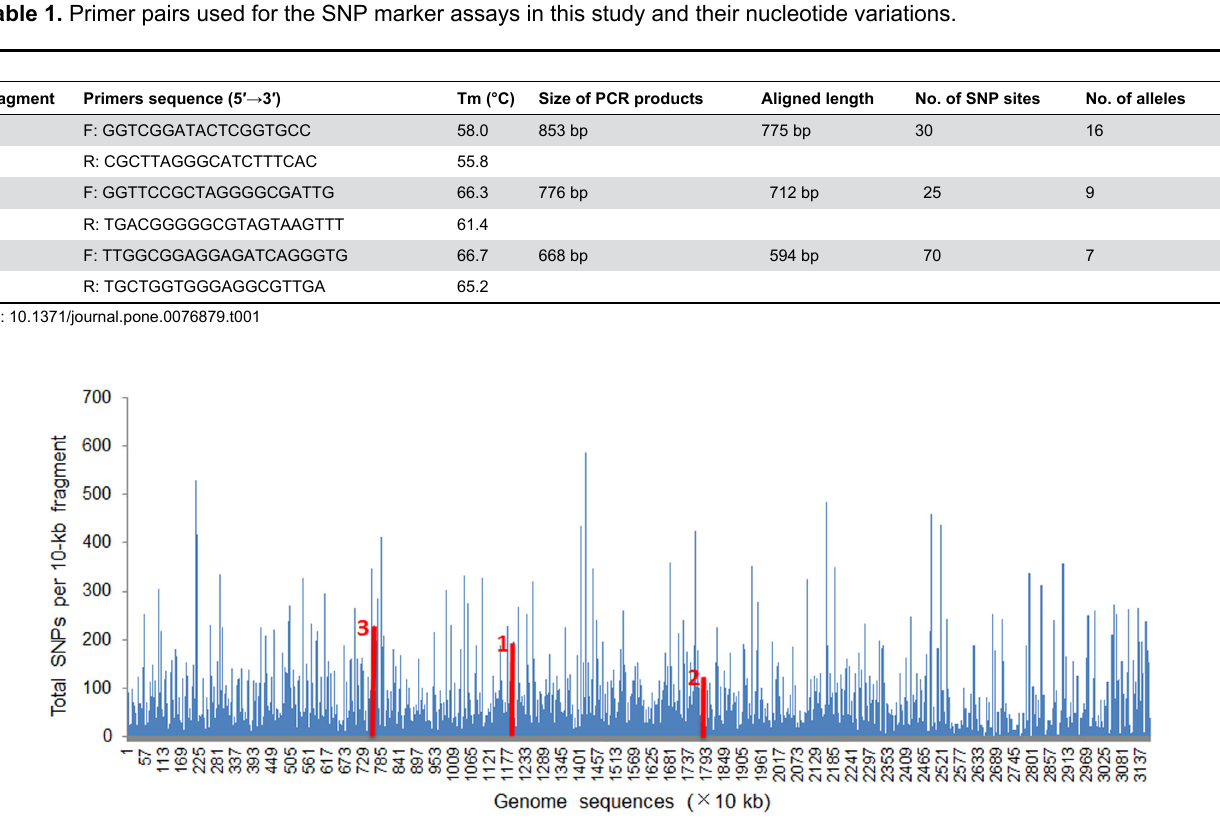
Table 1. Primer pairs used for the SNP marker assays in this study and their nucleotide variations.